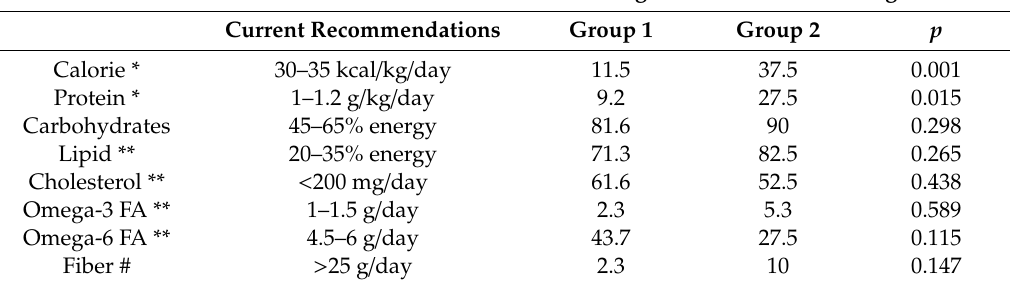
Table 5. Recommended daily dietary intake (mean ± SD) of nutrients and fibers and percentage of patients within the target value, according to the daily sodium intake (Group 1: < 1500 mg; Group 2: ≥ 1500